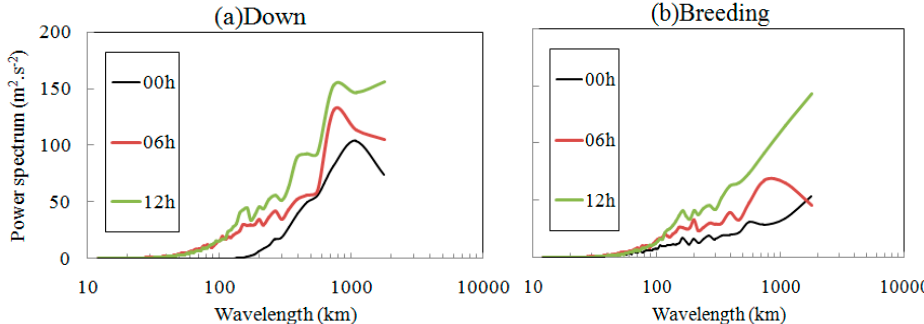
Figure 3. Member-averaged power spectra of the 500 hPa zonal wind perturbations as a function of wavelength for Down and Breeding. ( a ) Down and ( b ) Breeding.